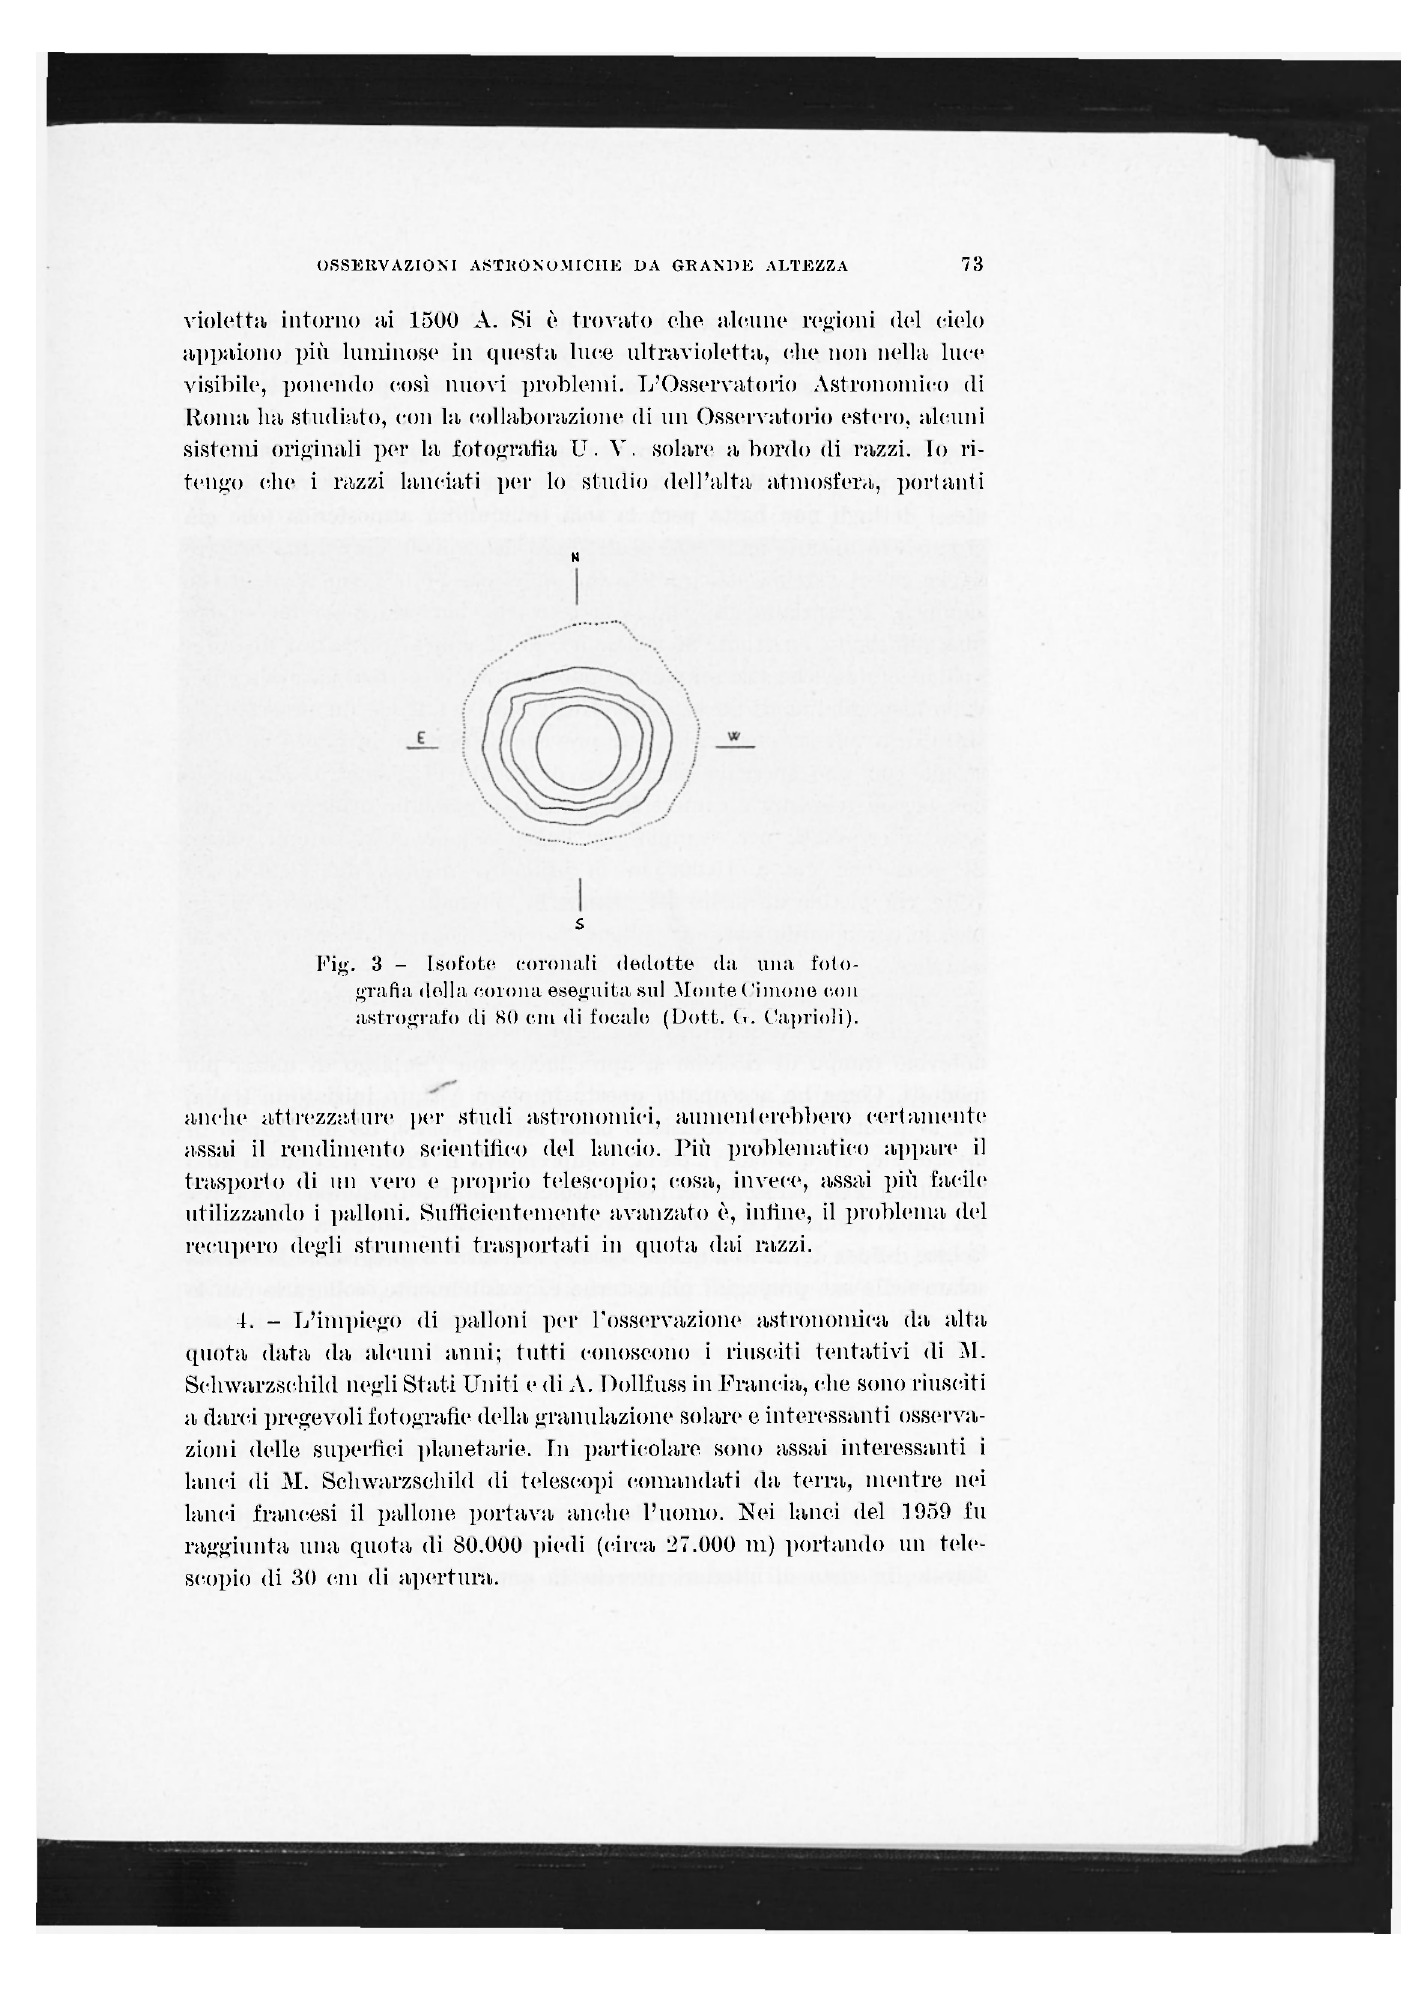
Fig. 3 fsofote coronali dedotte da una foto- grafia della corona eseguita sul Monte Cimone con astrografo di 80 cm di focale (Dott. Cr.